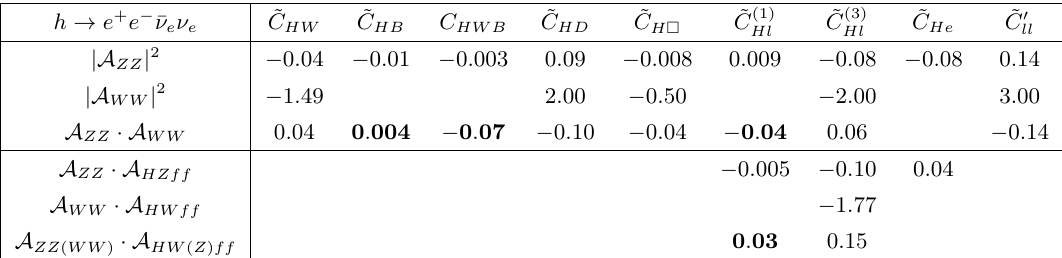
h ! (cid:22) uu (cid:22) dd